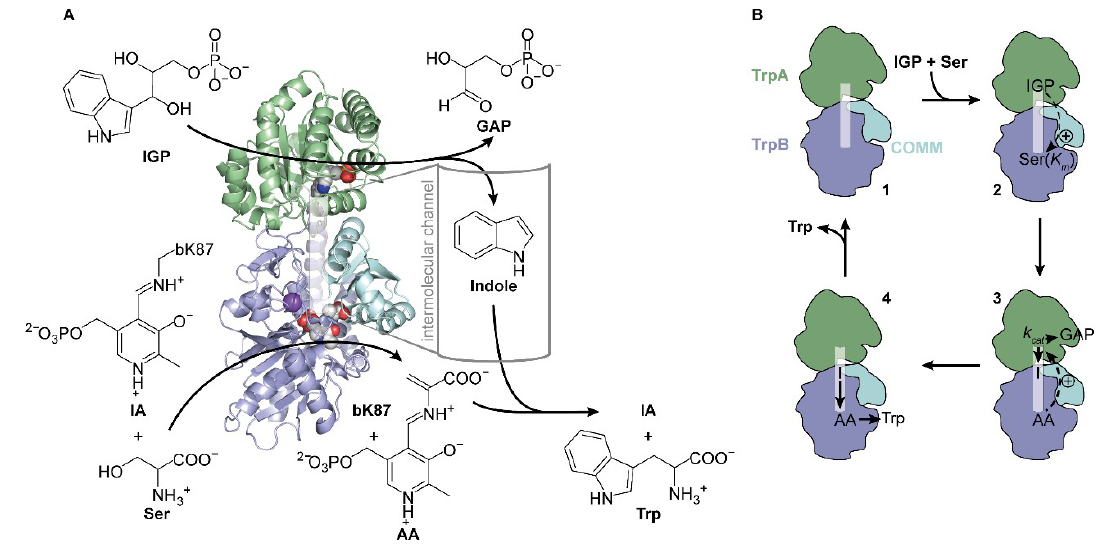
Figure 1. Scheme of the structure and function of tryptophan synthase (TS). ( A ) Reaction and crystal structure (PDB ID: 1a5s) of TS from S. typhimurium . TrpB (blue) catalyzes the condensation of serine (Ser) and indole to tryptophan (Trp) in the presence of the cofactor pyridoxal phosphate (PLP), which exists as internal aldimine (IA) bound to bK87 in TrpB. Serine initially condenses with IA to the aminoacrylate (AA), which further reacts with indole that is produced by TrpA (green) from indole-3-glycerol phosphate (IGP) and that travels through an intermolecular channel (transparent white) to the active site of TrpB. The active site of TrpA is marked by an IGP analogue, the active site of TrpB is marked by AA and a sodium cation, and the allosterically essential COMM domain is shown in cyan. ( B ) The activity of TS is tightly controlled by the presence of both substrates, IGP and serine, and by rearrangements of the communication domain (COMM). Starting from the apo-state ( 1 ), IGP positively stimulates binding of serine in TrpB, resulting in a lower K mSer value ( 2 ), while binding of serine and formation of AA leads to an increase of TrpA activity as manifested in a higher k cat value ( 3 ). After indole (I) channeling, reaction with AA, and subsequent release of tryptophan ( 4 ), the apo-state is regenerated ( 1 ).